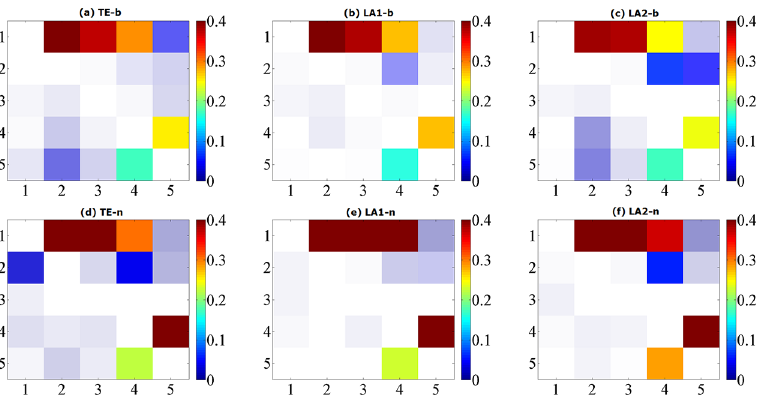
Fig 7. Matrix representations of the corresponding causalities for Model D. Retrieved by traditional TE method and two low-dimensional approximation methods, respectively by using binning entropy estimator (a, b, c) and NN entropy estimator (d, e, f) over 100 simulations of 1024 time points. The results are shown with color revealing the magnitude and transparency indicating the significance. The directions of causal influence are from row to column.